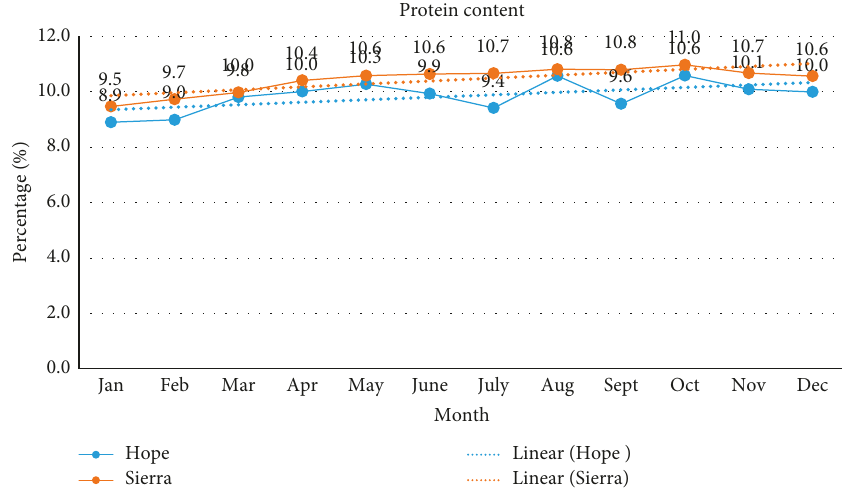
Figure 7: Comparison of protein content trends for Hope and Sierra malting barley varieties over the 12-month storage while Sierra had a strong positive correlation ( r : 0.786) as shown in Figure 9.